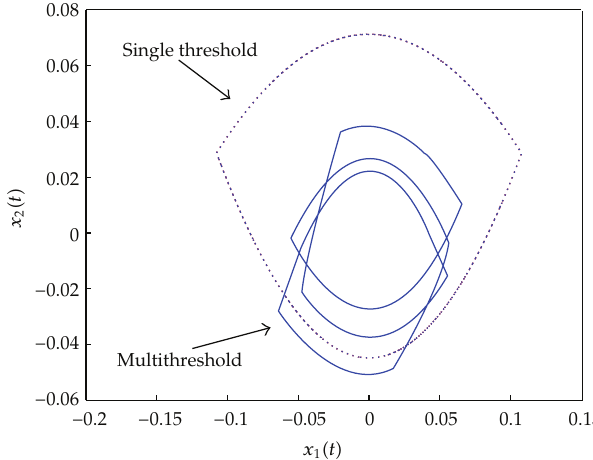
Figure 2: Phase plane plot for the solution versus its first time derivative exhibiting closed limit trajectories.